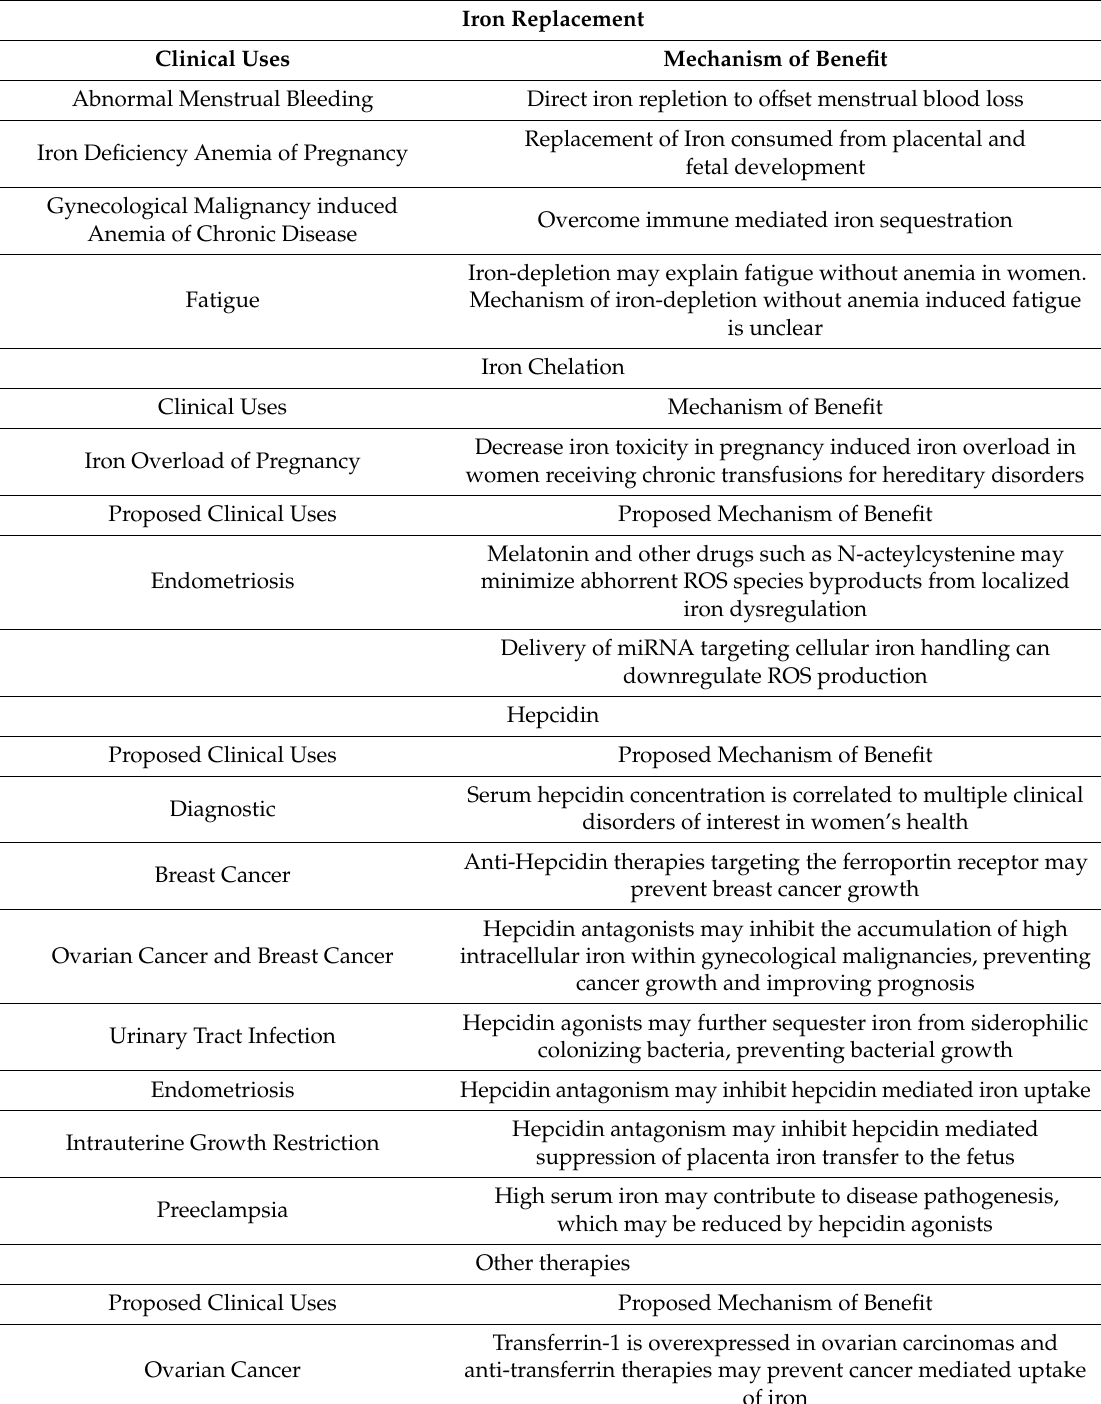
Table 2. Summary of iron related therapeutics in Women’s